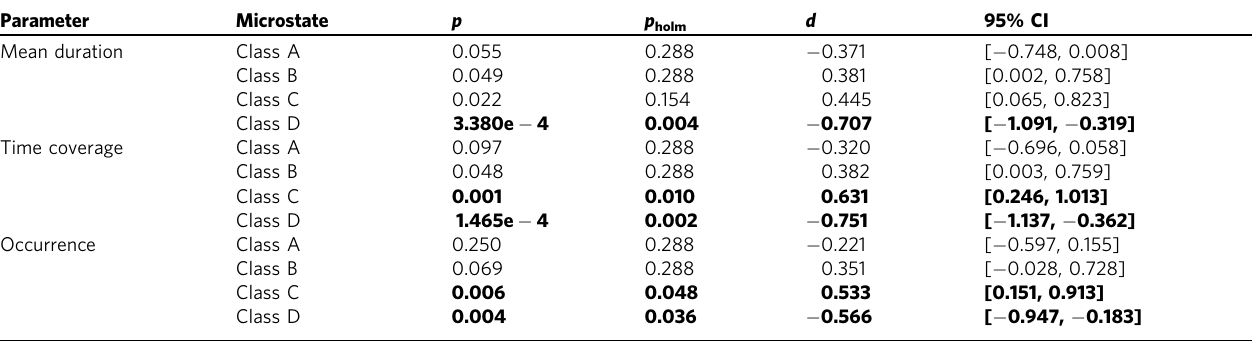
Table 2 Siblings vs. controls for all microstate parameters and for each microstate class. Parameter